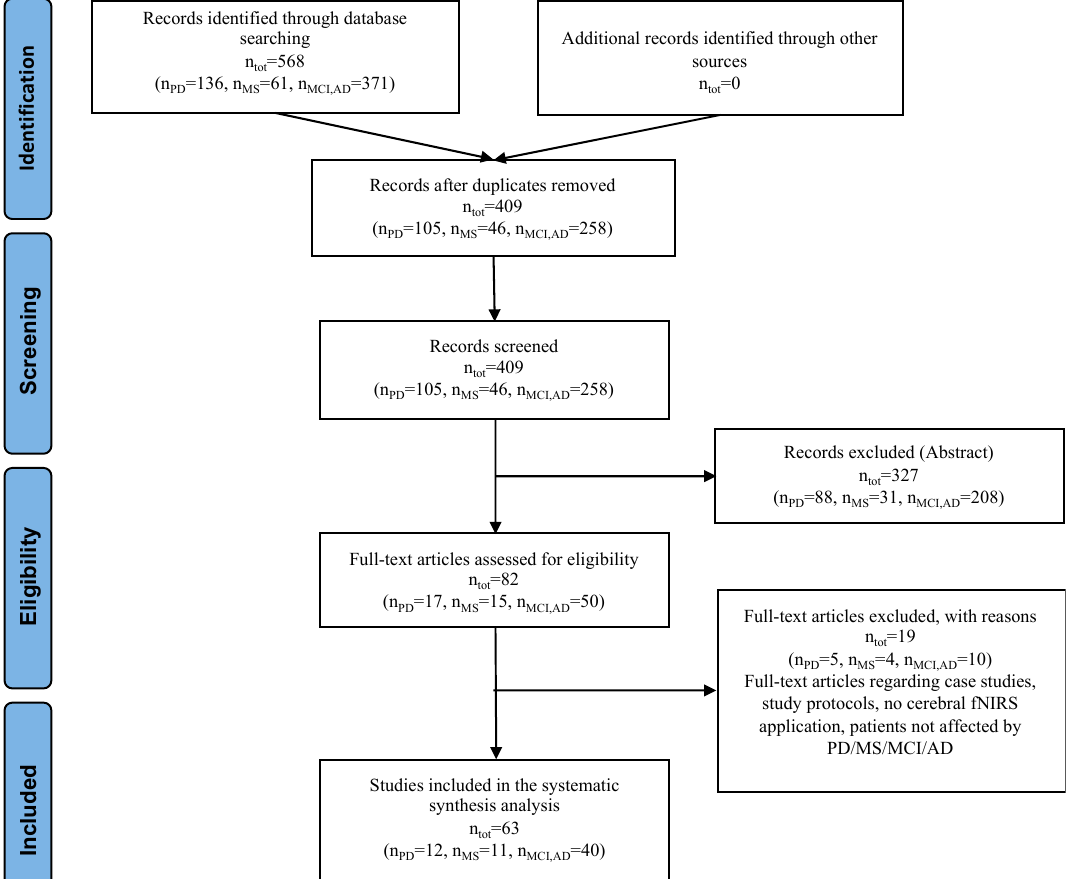
Figure 1. Preferred Reporting Items for Systematic Reviews and Meta-Analyses (PRISMA) checklist and flow diagram with information about the search, screening and selection processes performed in order to identify the relevant articles included in this review.